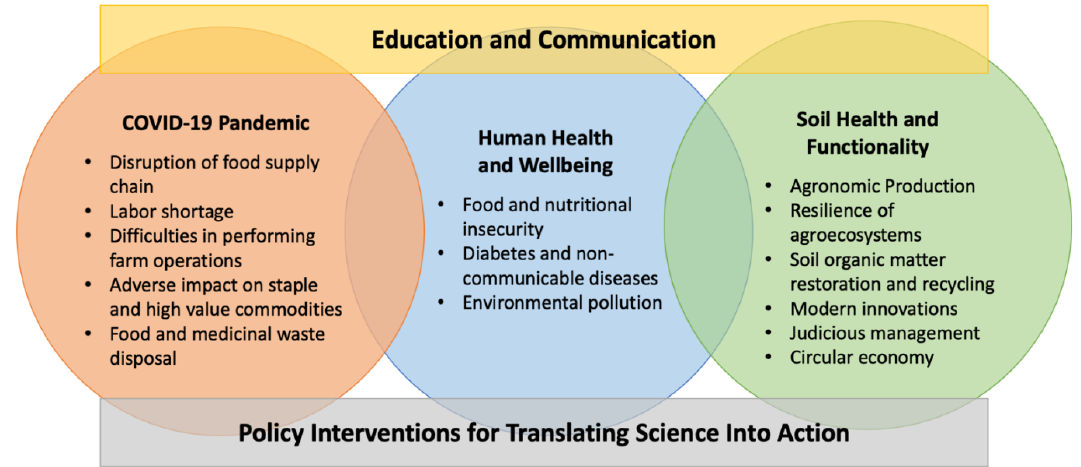
Figure 1. Sustainable management of soil resources for enhancing recovery from the COVID-19 pandemic by strengthening the food supply chain and improving environmental quality .